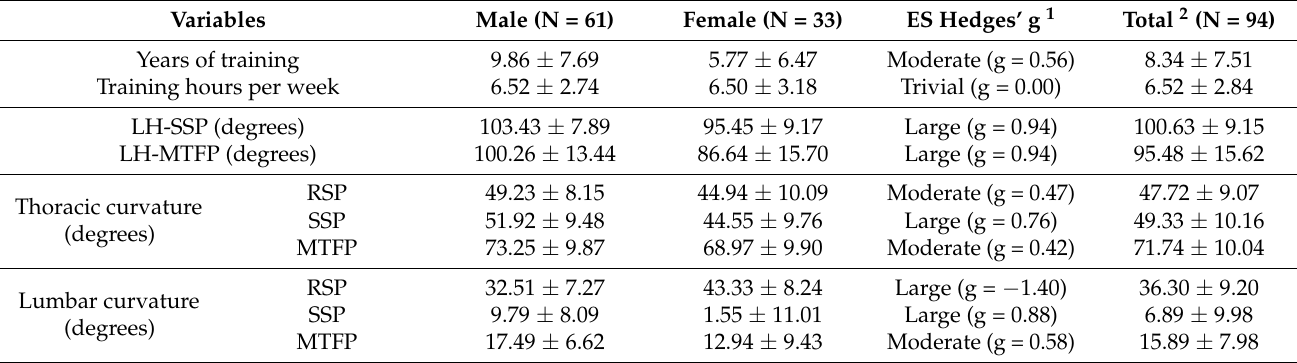
Table 1. Data related to sports participation, sagittal pelvic position, and sagittal spinal curvatures in competitive amateur